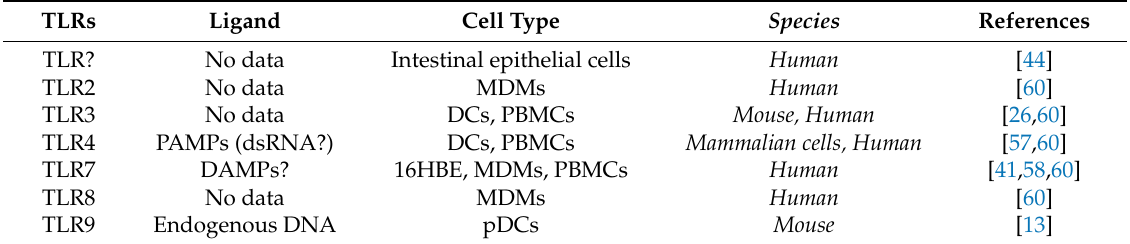
EV71 infection-associated toll-like receptors